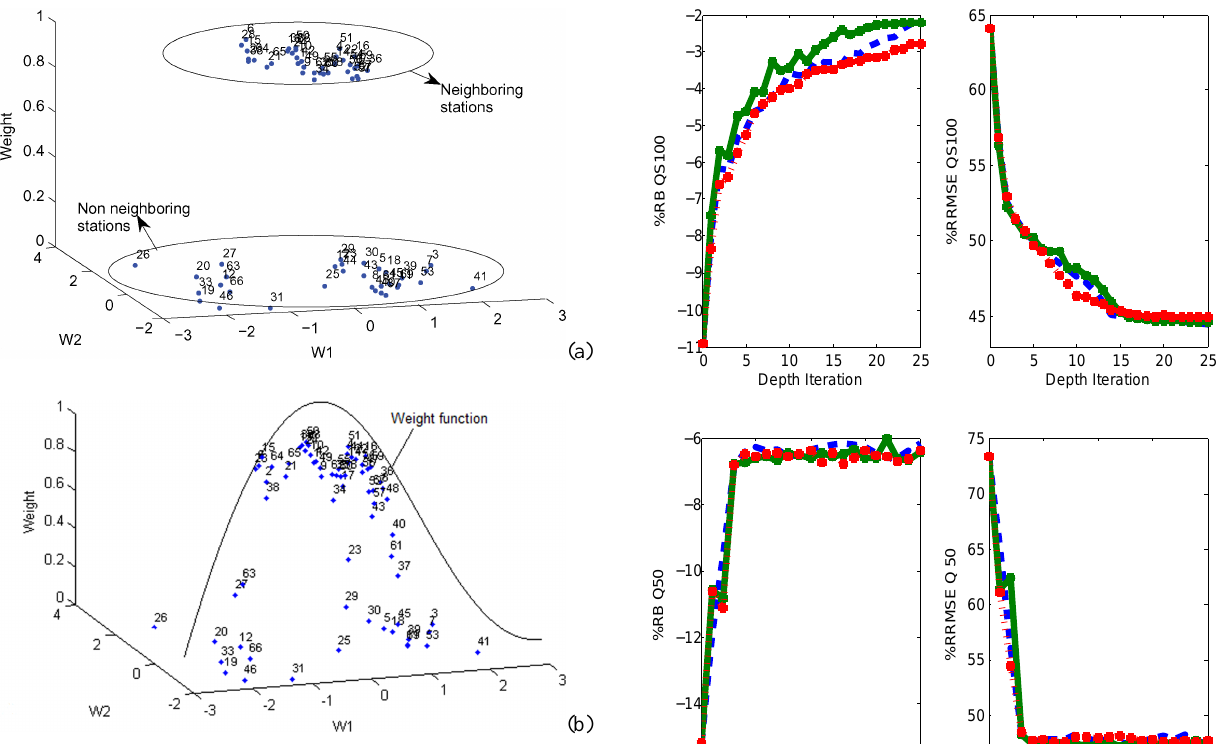
Fig. 6. Weight allocated to each gauged site to estimate the target- site number 25 in the Texas region in the canonical hydrological space (W1, W2) using (a) CCA with optimal α and (b) the DBRFA approach with optimal ϕ G .